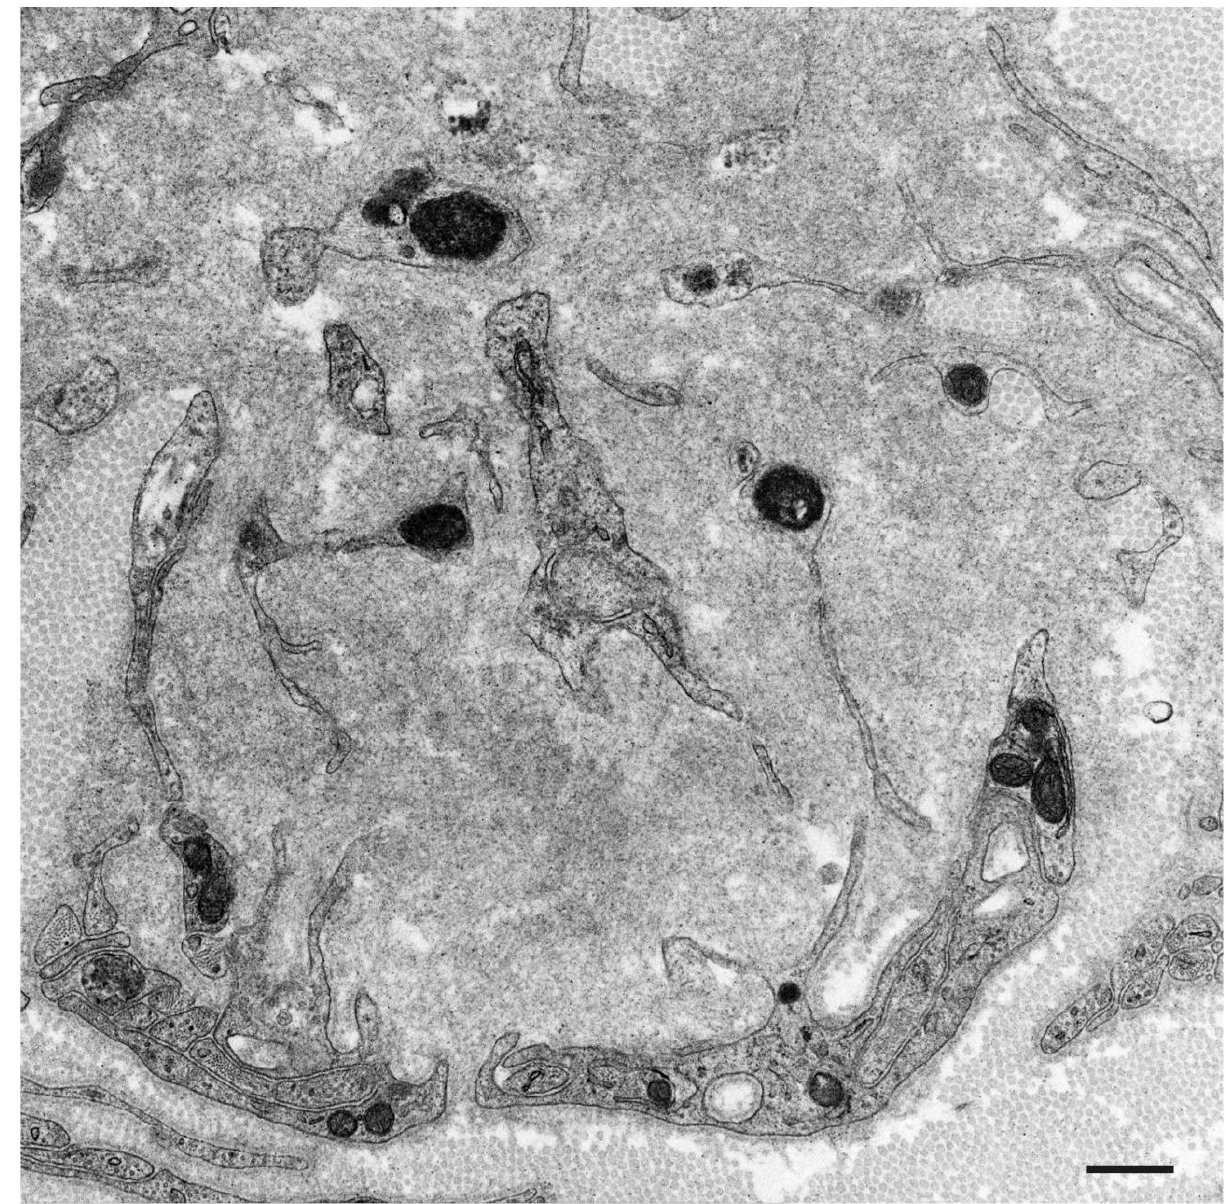
Figure 3. Subunits of Schwann cells surrounded by amyloid fibrils in AL amyloidosis. A cross-section of the sural nerve biopsy specimen. Schwann cells become atrophic and their basement and cytoplasmic membranes are indistinct [21]. Uranyl acetate and lead citrate stain. Scale bar = 0.5 μ m.